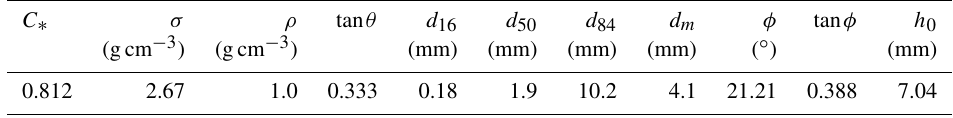
Table 4. Critical water depth of debris flow triggering in Guojuanyan gully. C ∗